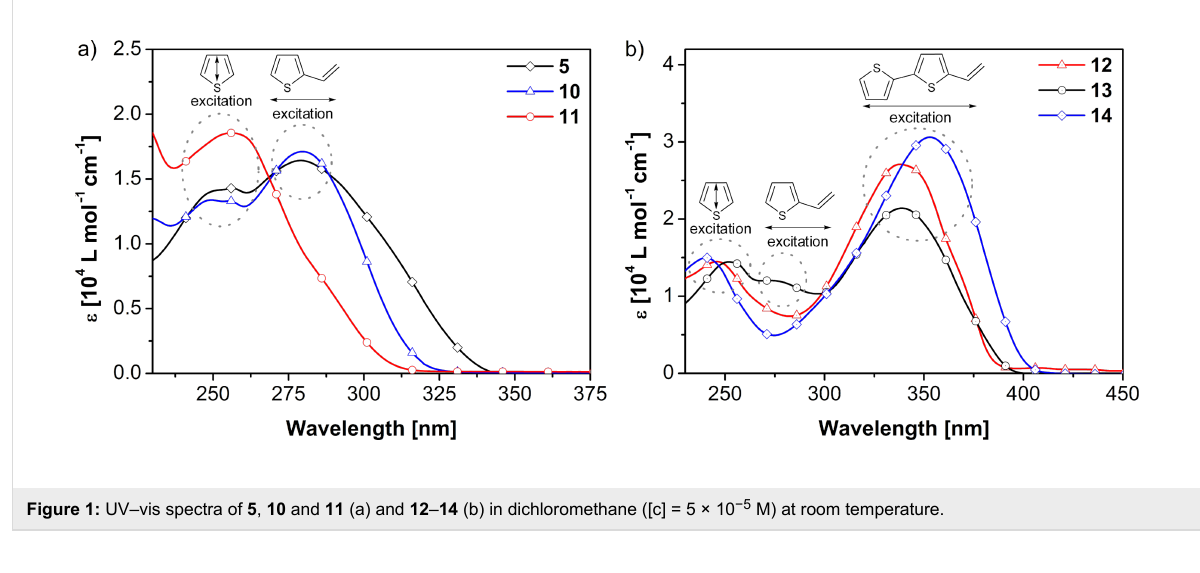
Figure 1: UV–vis spectra of 5 , 10 and 11 (a) and 12 – 14 (b) in dichloromethane ([c] = 5 × 10 − 5 M) at room temperature.